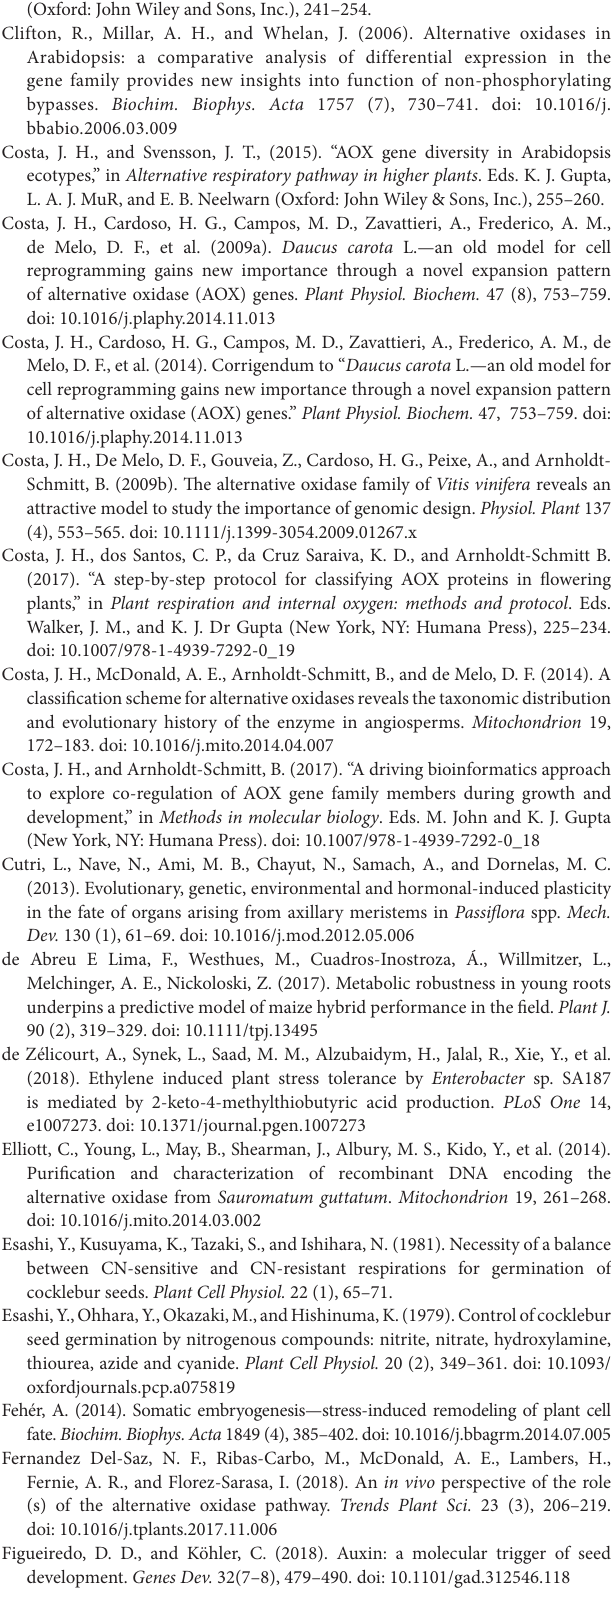
Figueiredo, D. D., and Köhler, C. (2018). Auxin: a molecular trigger of seed development. Genes Dev. 32(7–8), 479–490. doi: